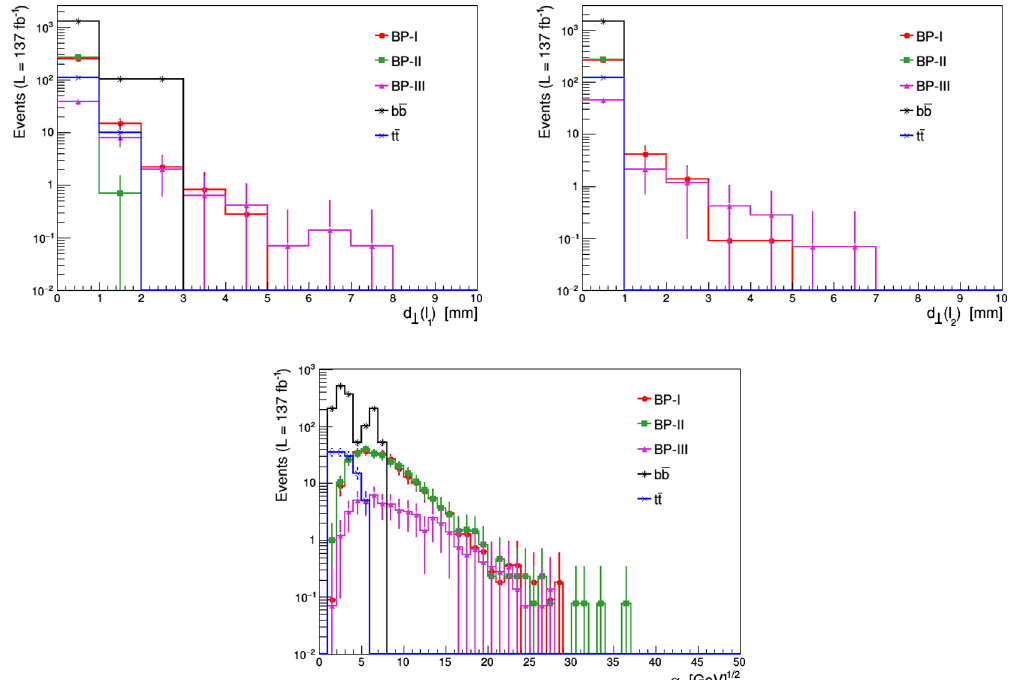
Figure 6 . Distribution of the transverse impact parameter ( d ⊥ ) of the leading (top-left) and sub- leading (top-right) lepton. Bottom: the distribution of α = (cid:26)(cid:26) p T √ events satisfying cuts